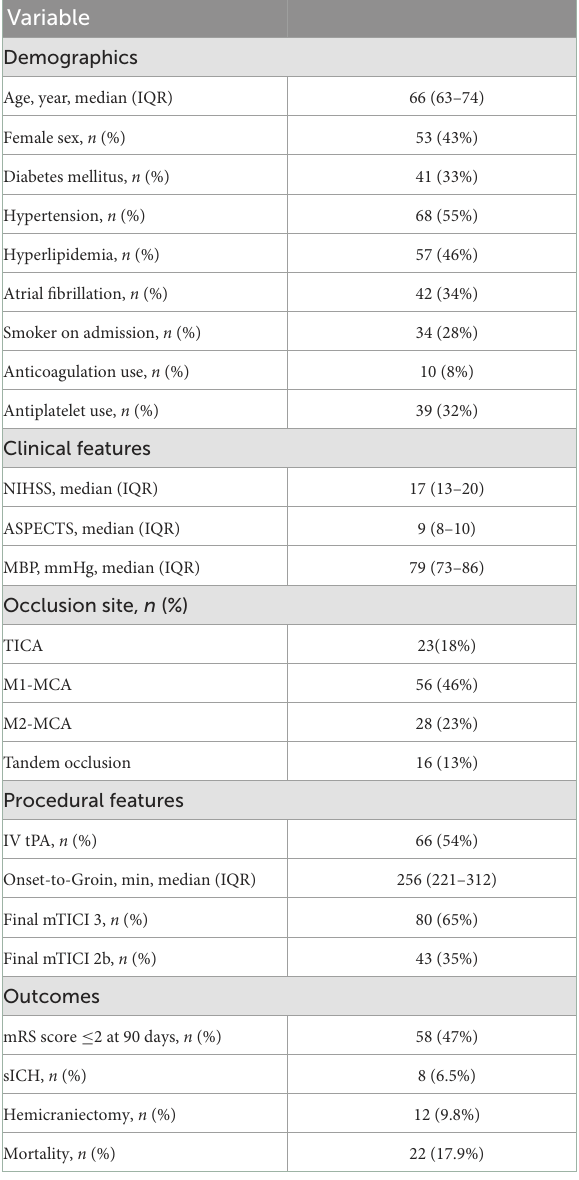
TABLE 1 Baseline characteristics and outcomes of the study cohort. Variable